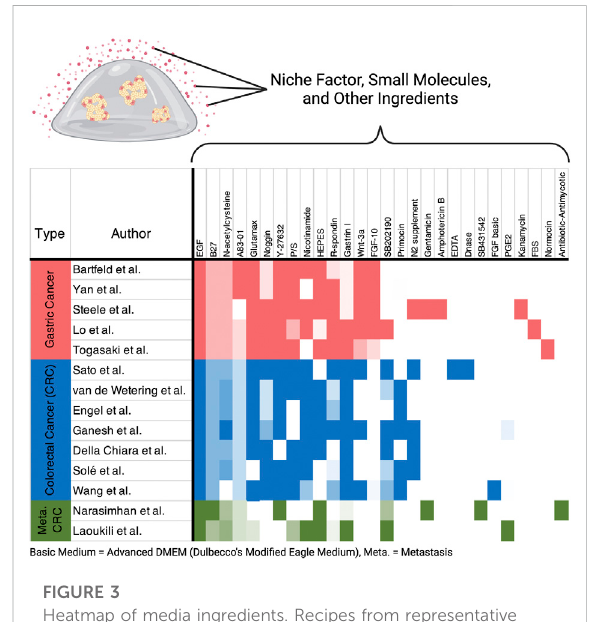
FIGURE 3 Heatmap of media ingredients. Recipes from representative research papers on gastric cancer and colorectal cancer (CRC) are included in the fi gure. Color intensity correlates with concentrations of each ingredient. Indescribable concentrations such as conditioned medium were normalized withintheingredients.Alltheingredientsandconcentrationdetails are listed in Supplementary Table